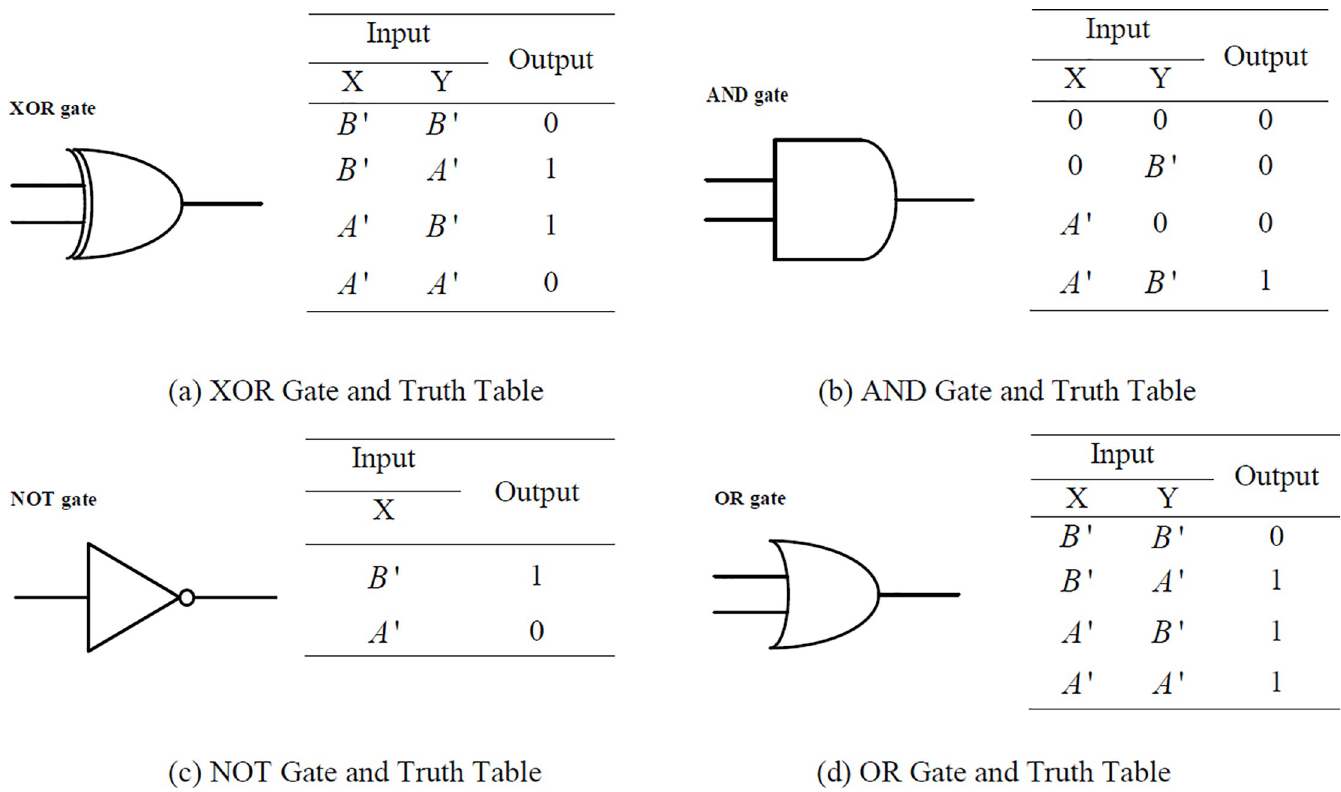
Fig 2. Four logic gates and truth table. (a) Input A ’ and input B ’ are set as "1" and "0", respectively. The output is "1" only upon the simultaneous addition of strands A ’ and B ’; Otherwise, the output is "0". (b) Both of the input A ’ and input B ’ indicate "1"; "0" indicates no input. (c) Add strand C ’ to displace C firstly, and then define input A ’ as "1" and input B ’ as "0". (d) Add strand D ’ to displace D first, and then define input A ’ as "1" and input B ’ as